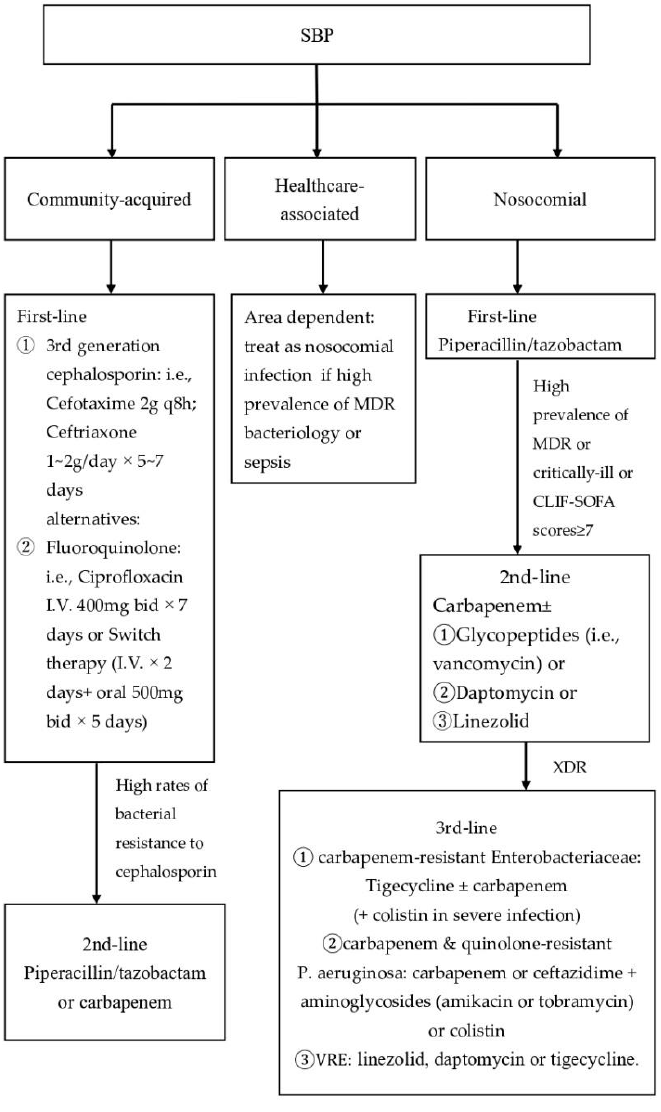
Figure 2. Recommended antibiotic treatment strategy for SBP since 2018.